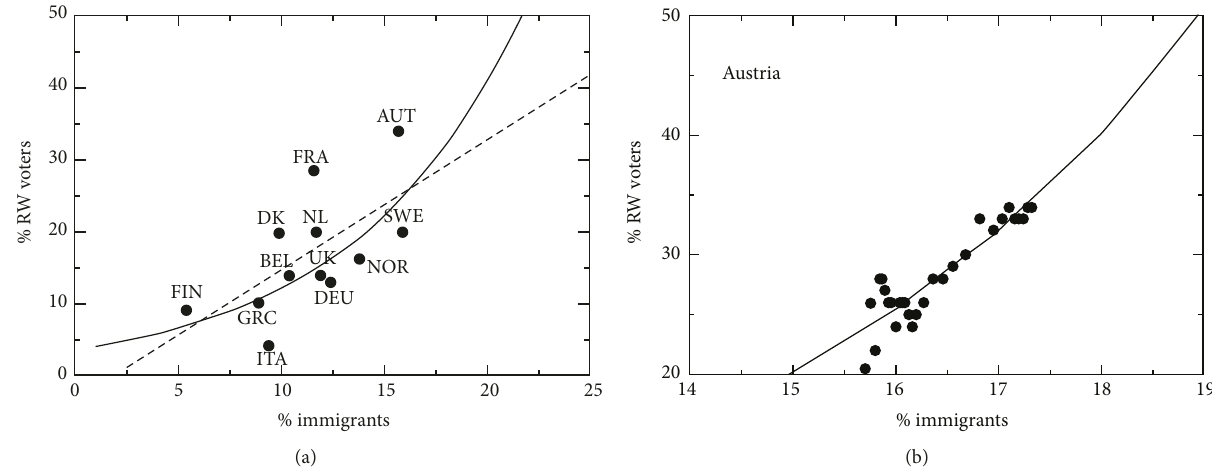
Figure 1: Immigration affects the support for right-wing populism I . (a) Among the EU countries involved in the recent migrant crisis, support for RW populism is generally higher in those countries that accepted a larger number of immigrants relative to the country’s population size. Shown is June 2016. Seeing democracy as the majority rule principle, we presume that RW populism becomes a dominant political option when the percentage of RW voters exceeds 50%. Judging based on a cumulative exponential function that fits the data reasonably well— 𝑦 = 4.43 exp (0.097𝑥) —RW populism in the examined EU countries may take over if the percentage of immigrants in the total population approaches 22%. Shown is also a linear fit 𝑦 = −3.67 + 1.80𝑥 roughly giving that the RW populism reaches the majority for the percentage of immigrants equal to approximately 30%. Coefficients of determination ( 𝑅 2 ) for the two models are 0.3866 and 0.4077, respectively. Akaike weights indicate that, given the dataset at hand, the exponential model is better with probability 44.3%, while the linear model is better with the remaining probability 55.7%. (b) Similar as in the other EU countries, Austrian data reveal that the increase in the percentage of immigrants is accompanied with an increase in the percentage of RW populist voters. Here too a cumulative exponential function fits the data well. This function predicts the rise of RW populism in Austria when the percentage of immigrants is slightly below the 20%